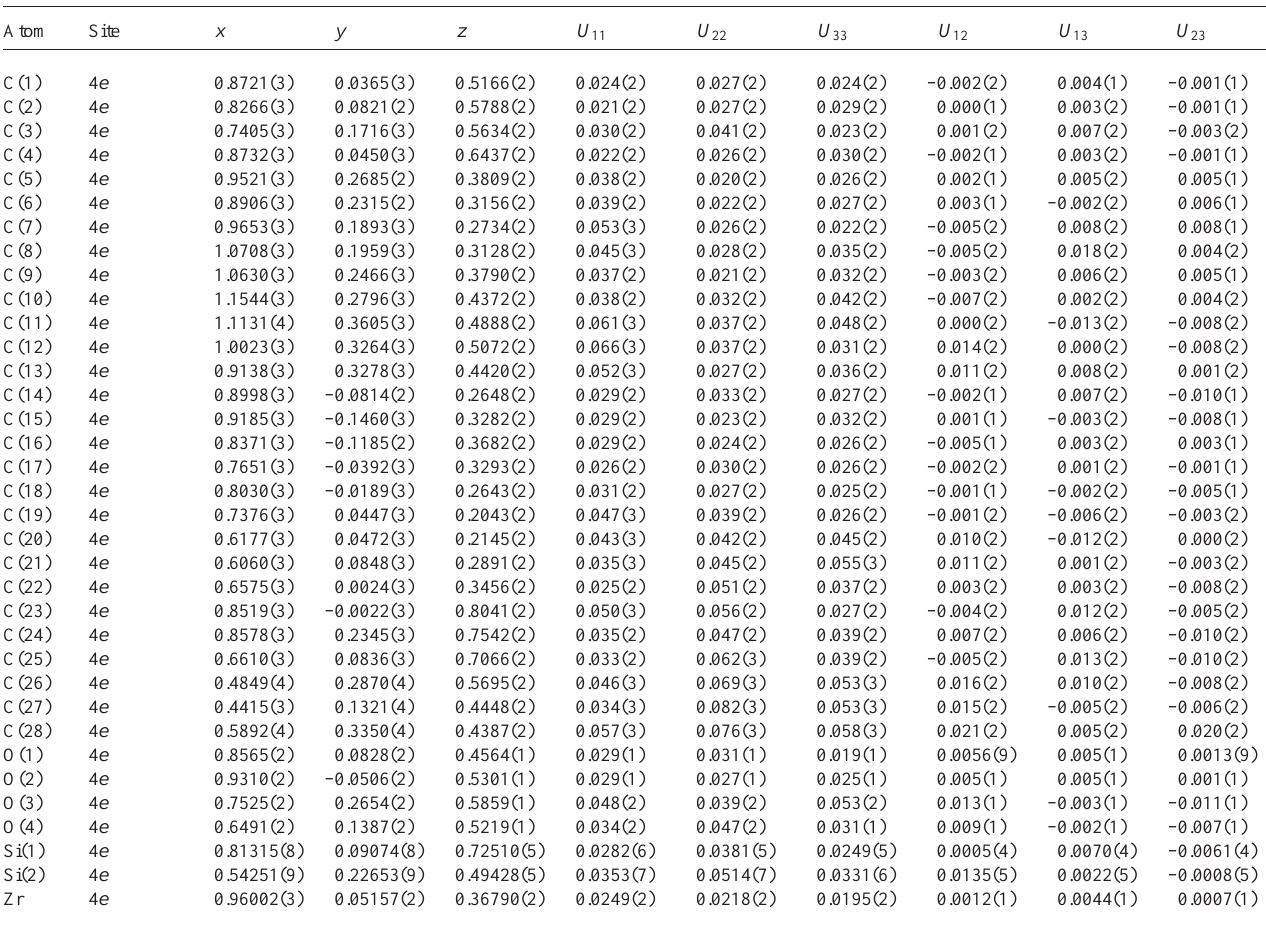
Table 3. Atomic coordinates and displacement parameters (in Å 2 )